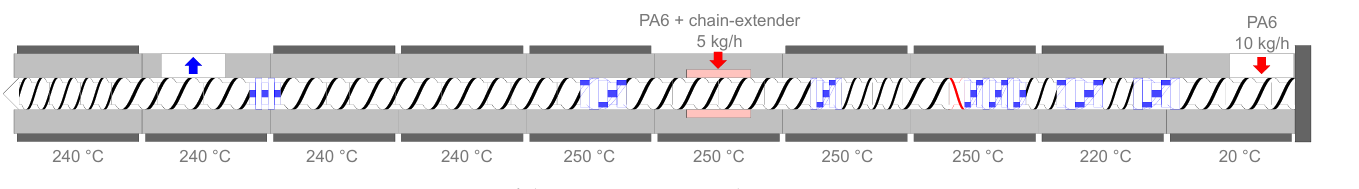
Figure 2. Design of the twin screw